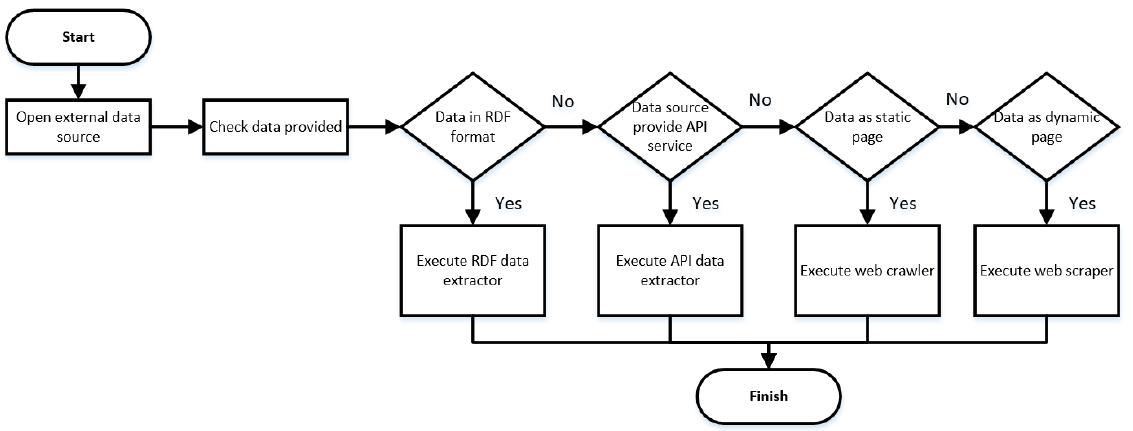
Figure 5. The flowchart in selecting data extractor tools.